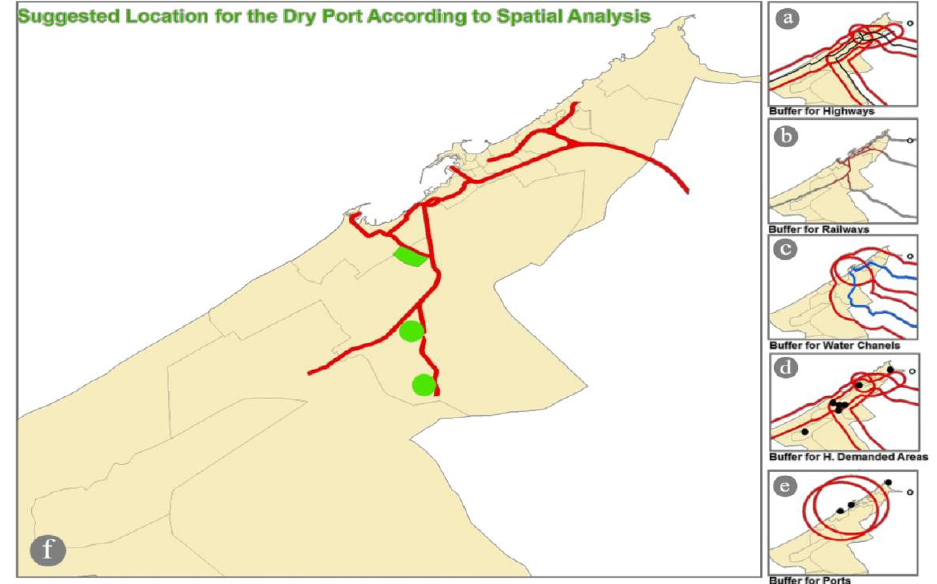
Figure 8. The suggested location for the dry port according to spatial analysis.